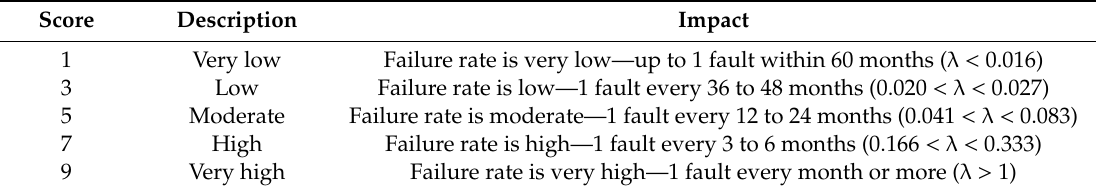
Table 5. Mean Time Between Failures (MTBF) Impact Scores and Description.